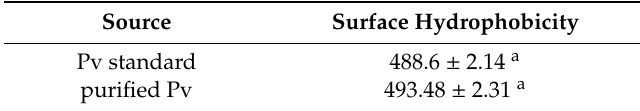
Table 9. Hydrophobicity of Pv standard and purified